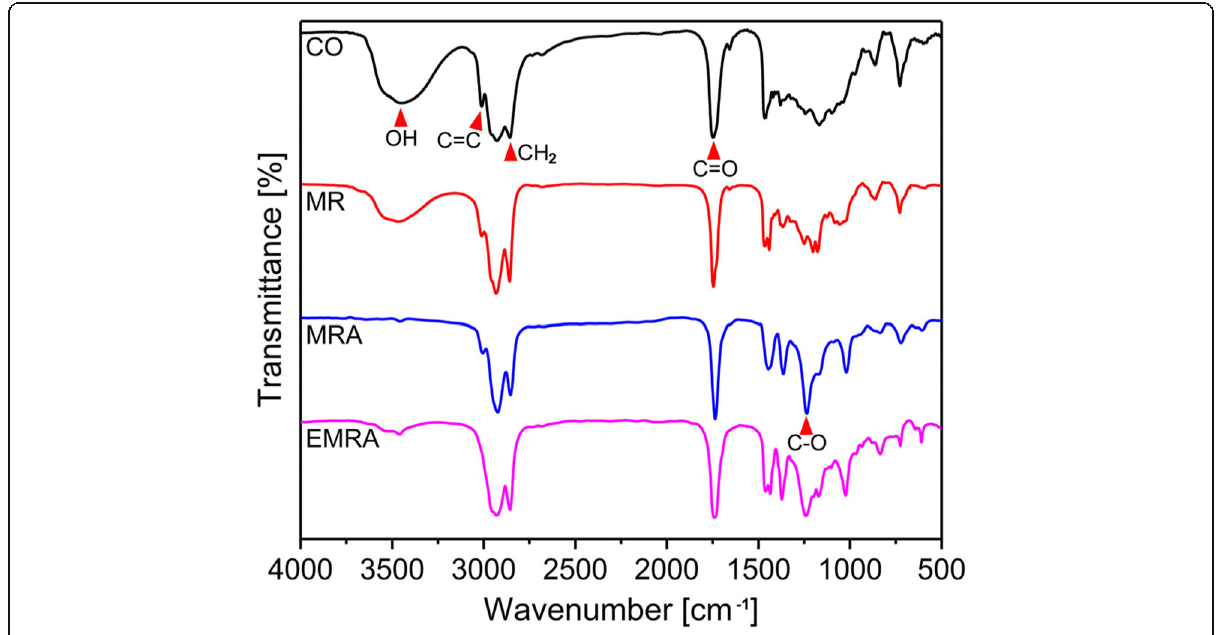
Fig. 1 FT-IR spectra of CO, MR, MRA, and